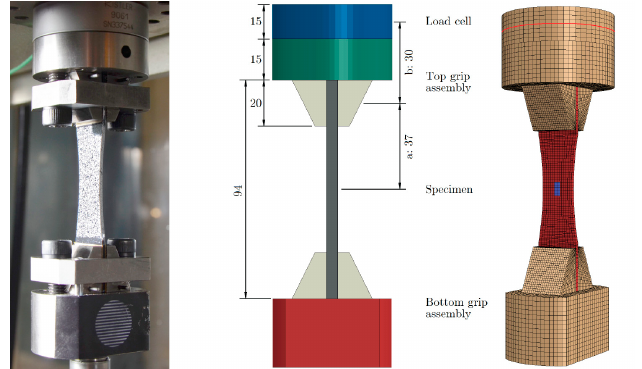
Figure 3. A picture of the set-up ( left ), dimensions of the dynamic tensile test set-up in mm ( middle ), and the meshed FE model ( right ). The red line and blue area in the model show the force- and strain calculation surface areas,